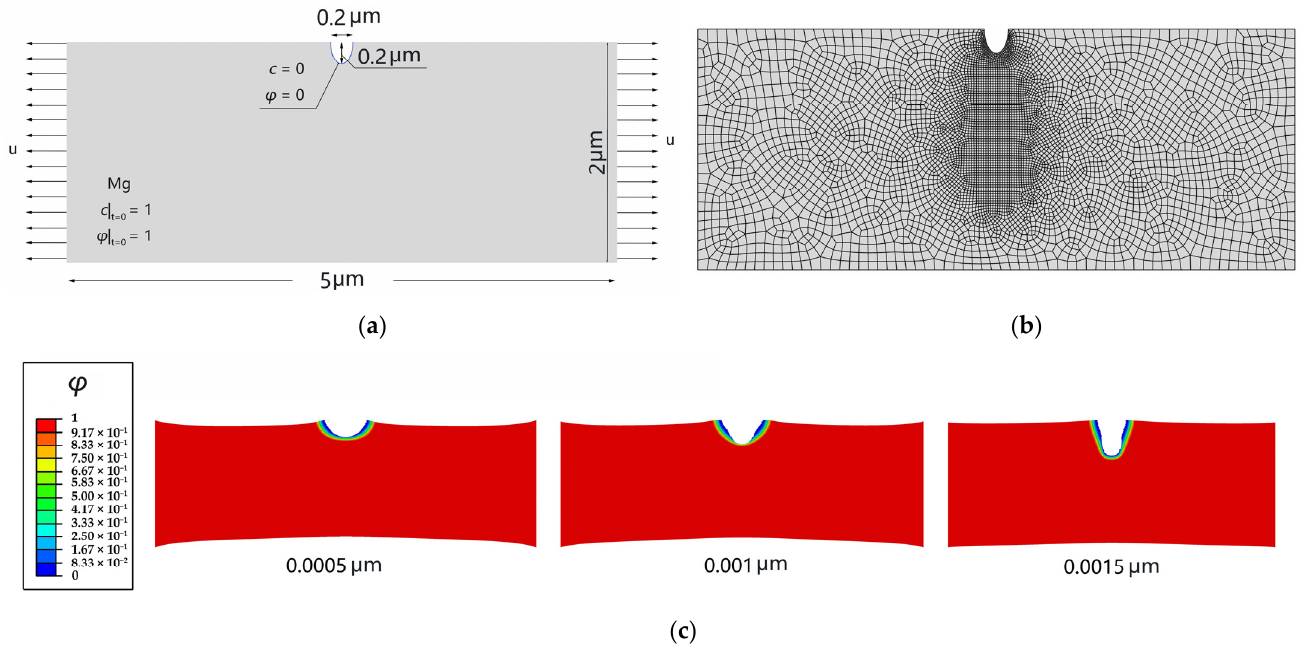
Figure 6. SCCD of a rectangular Mg crystal: ( a ) geometry with initial and boundary conditions for c and ϕ ; ( b ) finite element mesh; ( c ) SCCD of a rectangular Mg crystal with different displacement. Table 3. Mechanical and corrosion parameters of SCCD for Mg.